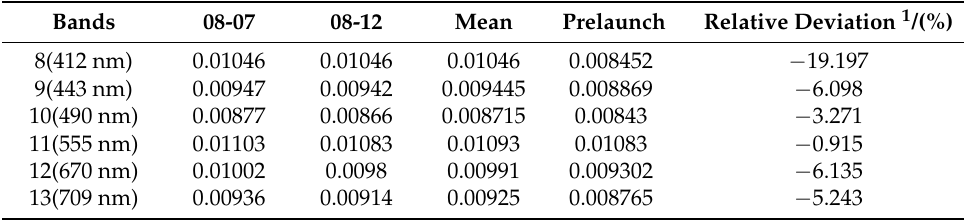
Table 9. Vicarious calibration coefficient of FY-3D/MERSI-II at the Dunhuang RCS. Bands